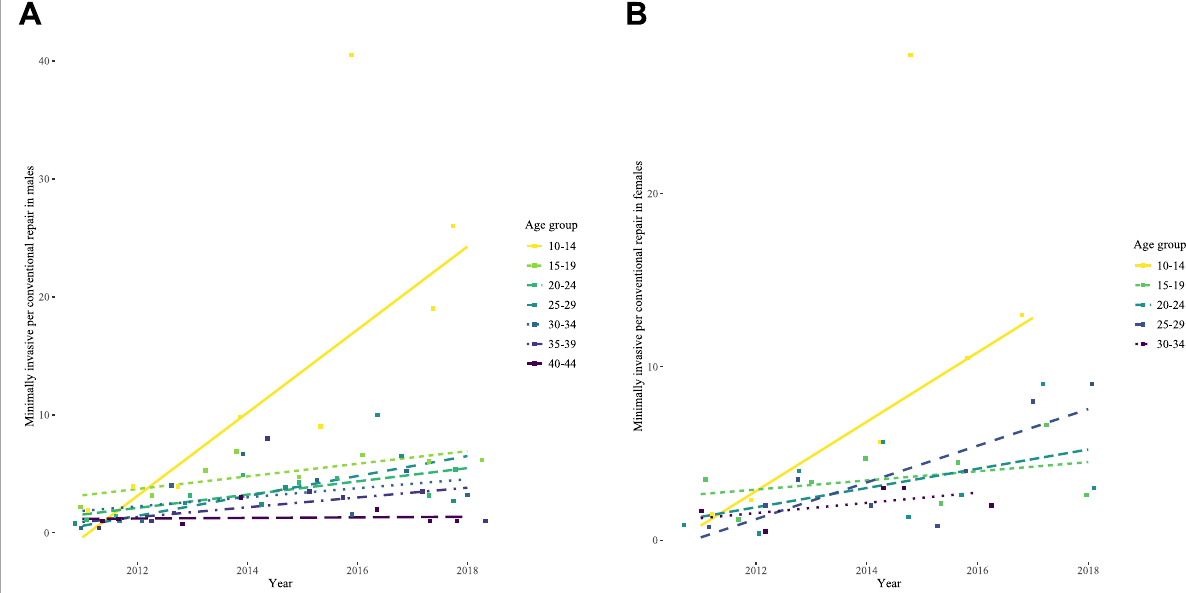
Fig. 4 Ratio of minimally invasive and conventional funnel chest repairs. A Procedures conducted in males. B Procedures conducted in